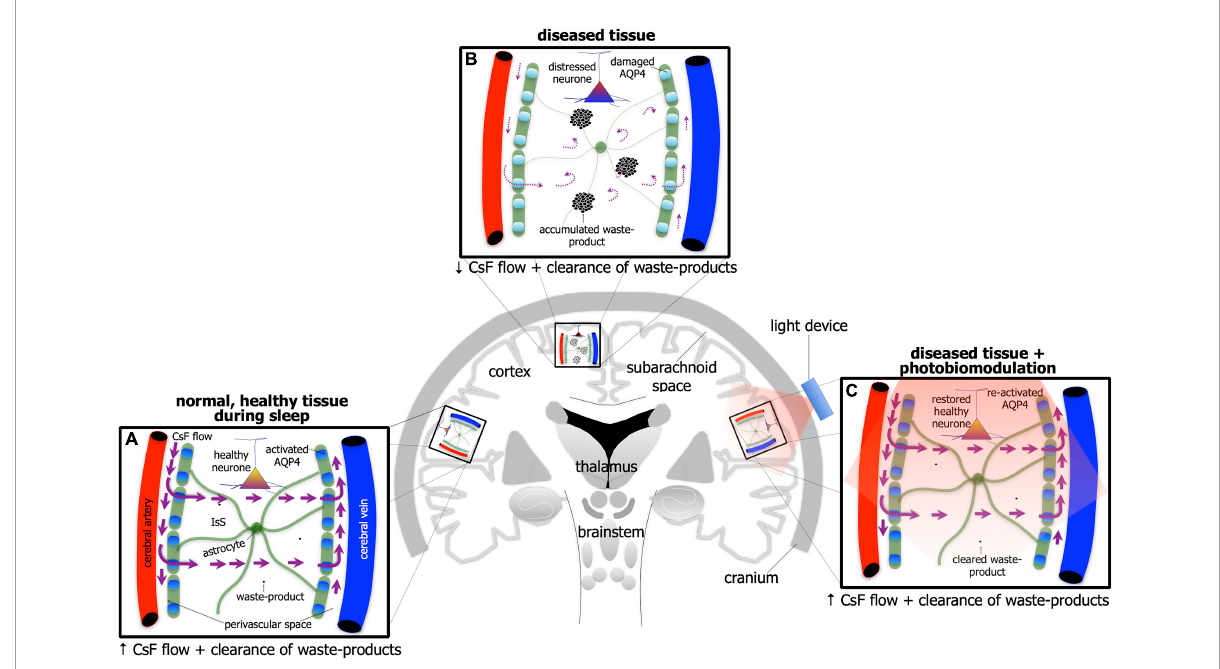
FIGURE4 Schematic diagram of the brain highlighting the glymphatic system - the house-keeper of the brain – in normal, healthy tissue during sleep (A) , in disease [ (B) ; e.g., Alzheimer’s disease] and in disease after photobiomodulation treatment (C) . Glymphatic activity is reduced greatly in disease [represented by thinner astrocyte processes, thinner/curved arrows of cerebrospinal (CsF) flow through interstitial space (IsS), accumulated waste-product and lighter-colored (damaged) aquaporin protein in (B) compared to normal (A)] . After photobiomodulation treatment, glymphatic activity is restored [represented by thicker astrocyte processes, thicker arrows of CsF flow through IsS, cleared waste-product and darker-colored (re-activated) aquaporin protein in (C) as well as neuronal